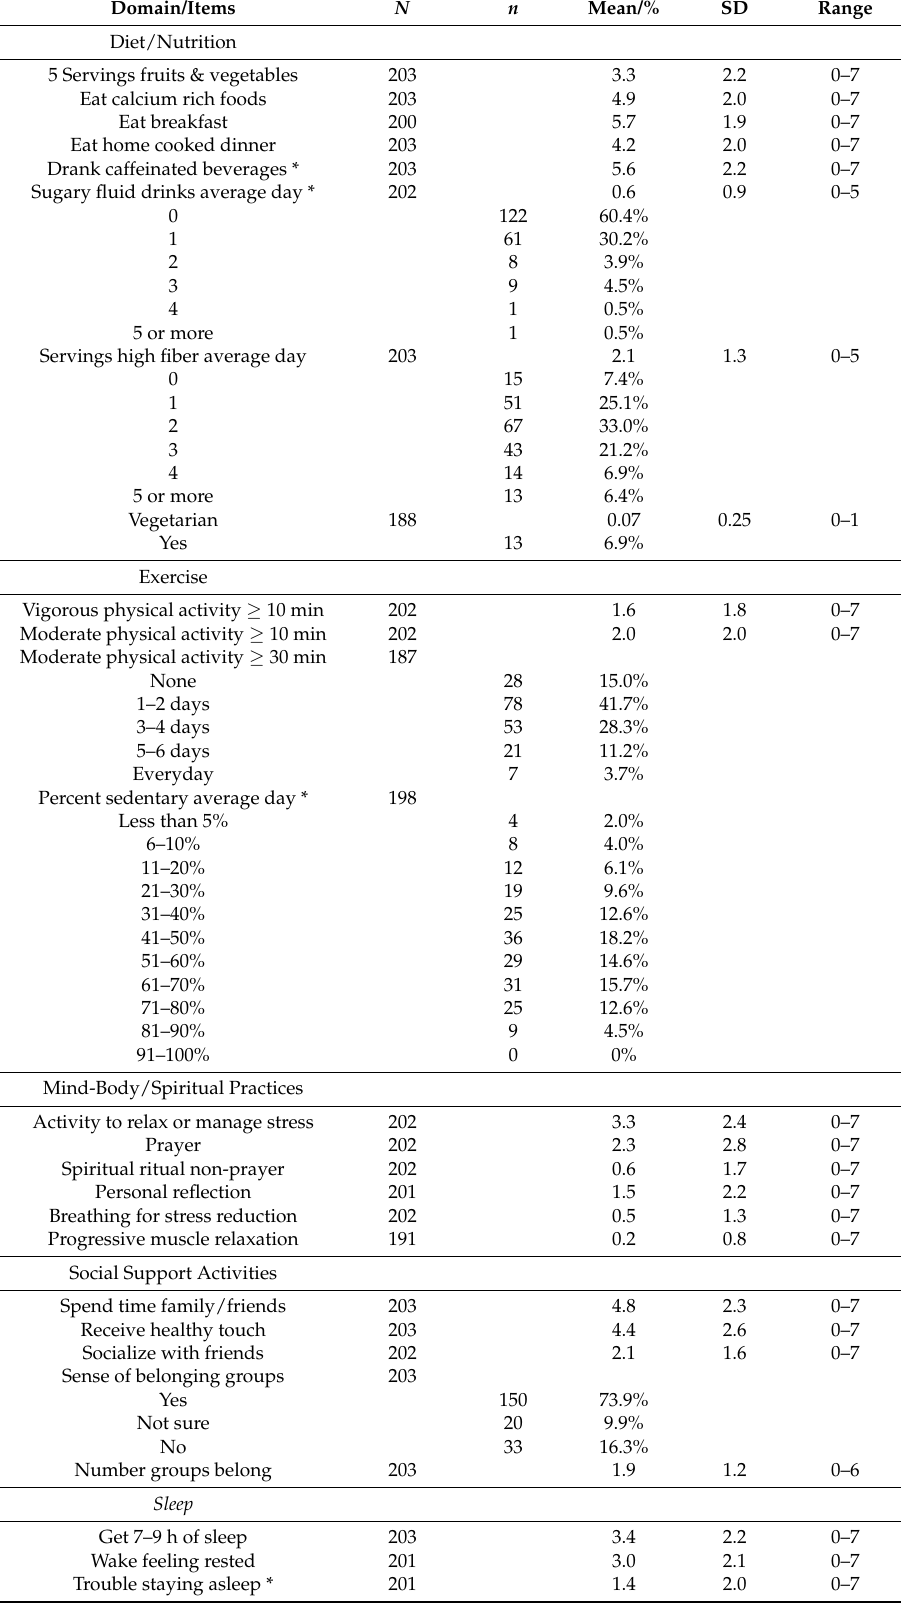
Table 3. Lifestyle behaviors—descriptive